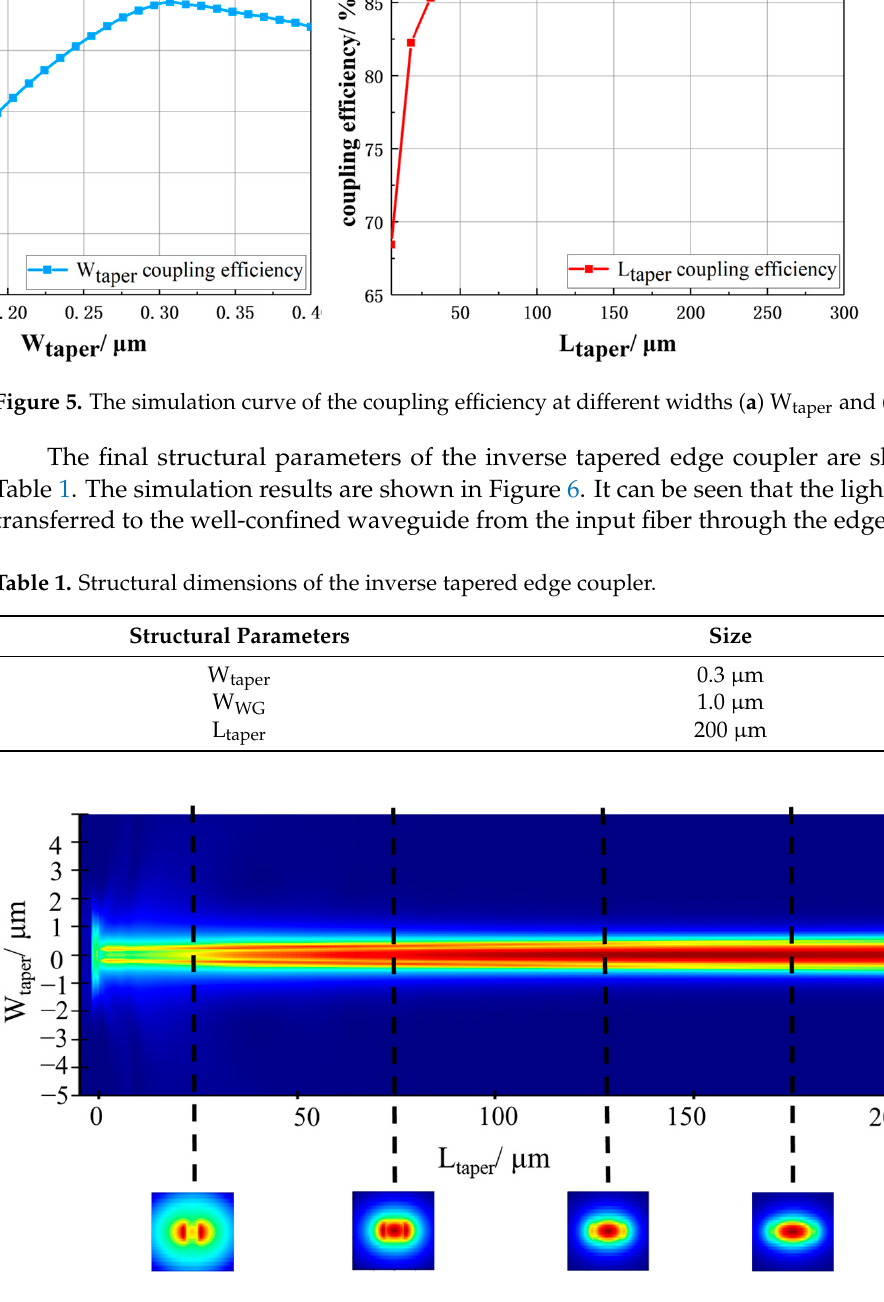
Figure 4. Schematic of inverse tapered edge coupler.